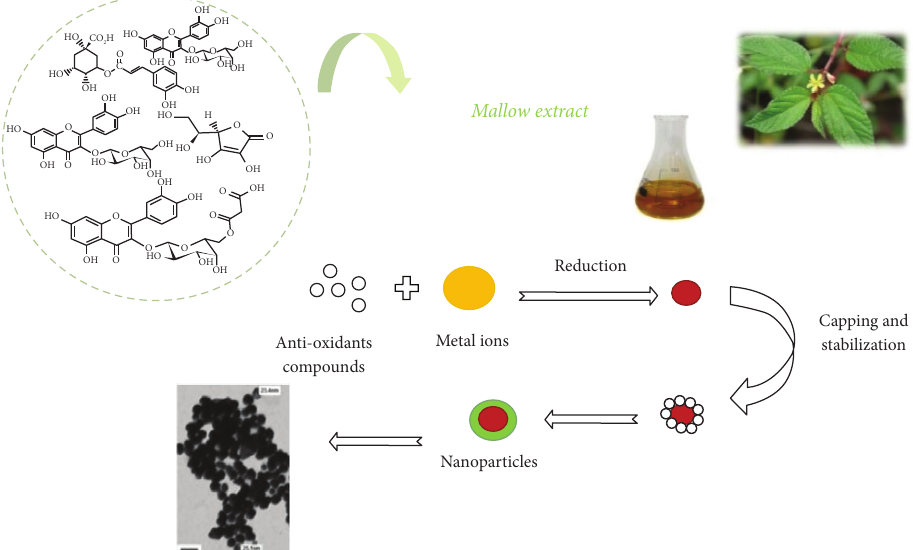
Figure 7: Schematic representation of metallic NPs synthesis using plant extracts. Image source and credit